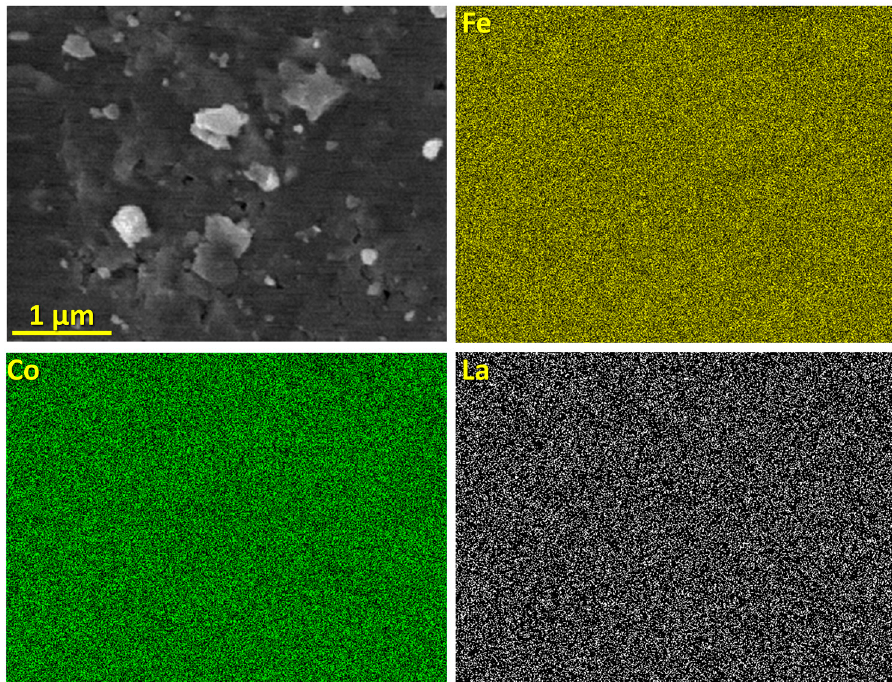
Figure 3. Chemical distribution of (Fe 0.65 Co 0.35 ) 0.95 (La 2 O 3 ) 0.05 sample.